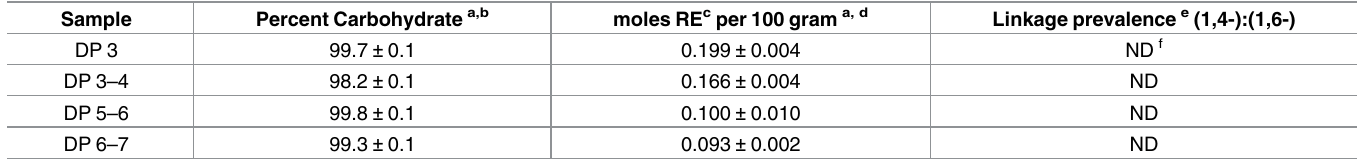
Table 1. Chemical characterization of four MOS samples prepared for psychophysical